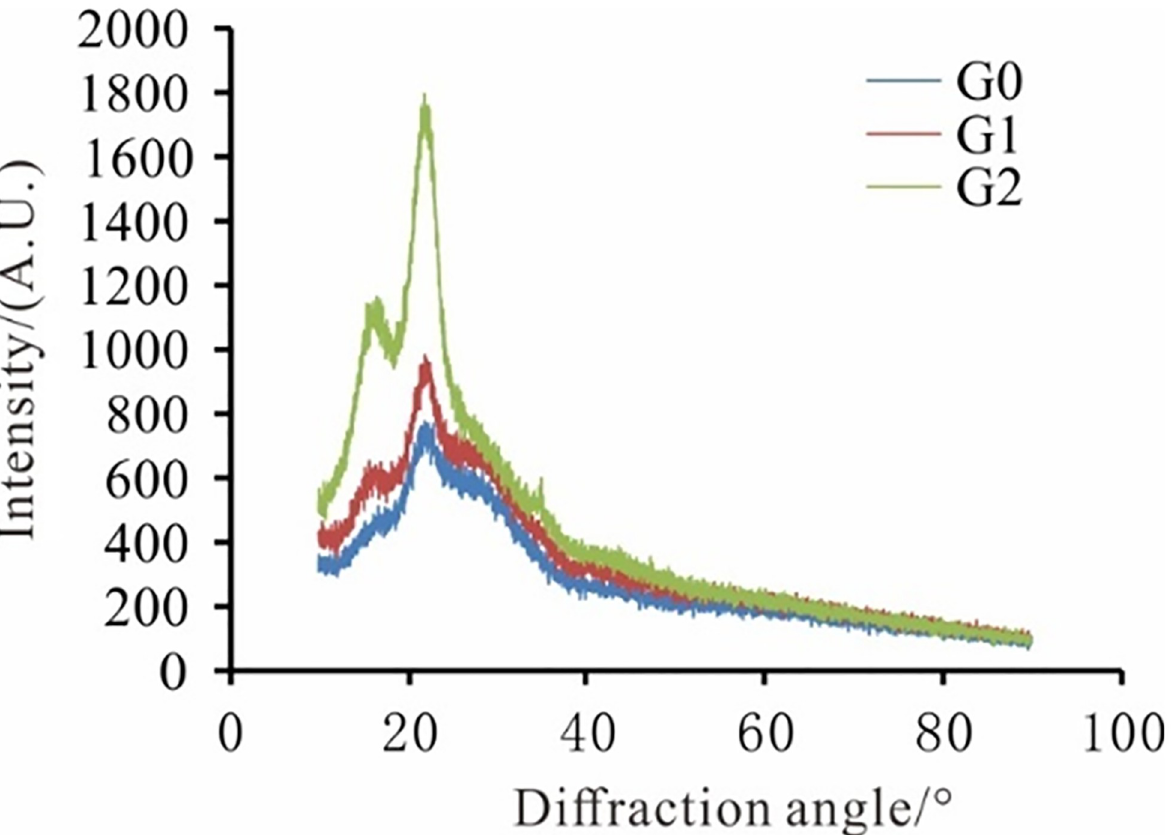
Fig 7. XRD patterns of wheat straw from different fermentation